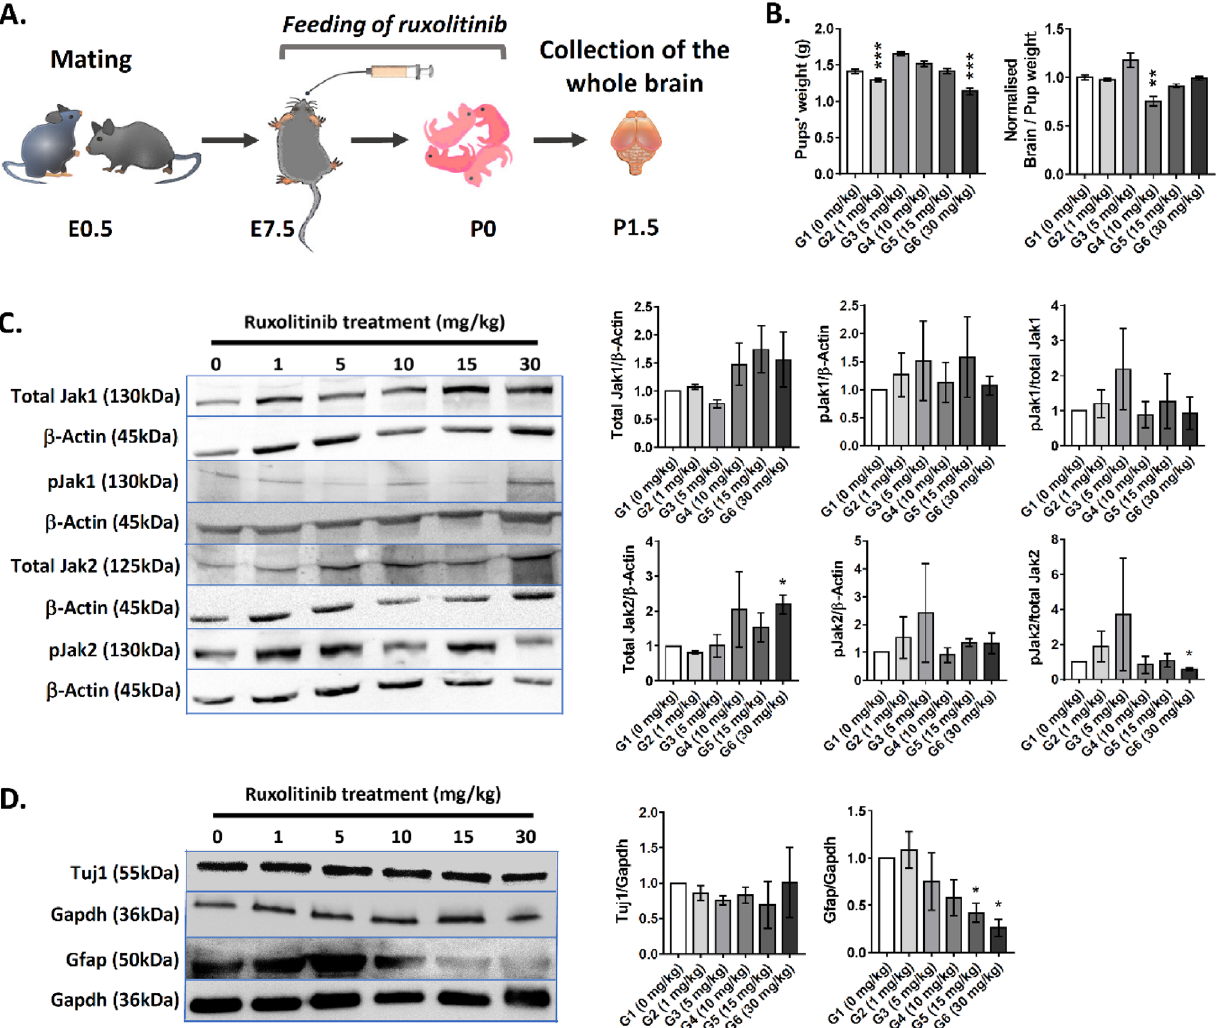
(G2-G6). ( C ) Immunoblotting analysis for total Jak1 and Jak2, and phosphorylated Jak1 and Jak2 expression in all groups. The corresponding relative pixelation analysis of immunoblotting bands is shown right to the blots (n = 3 per group; unpaired, two-tailed Welsh’s t test). ( D ) Immunoblotting analysis for Tuj1 and Gfap markers in P1.5 whole brains in all groups and the corresponding relative pixelation analysis of immunoblotting bands is shown right to the blots (n = 3 per group; unpaired, two-tailed Welsh’s t test). All values represent mean ± SEM; * denotes adjusted p < 0.05; ** denotes adjusted p < 0.01; *** denotes adjusted p < 0.001. See Figs. S1 and S2 for original immunoblots (Supplementary